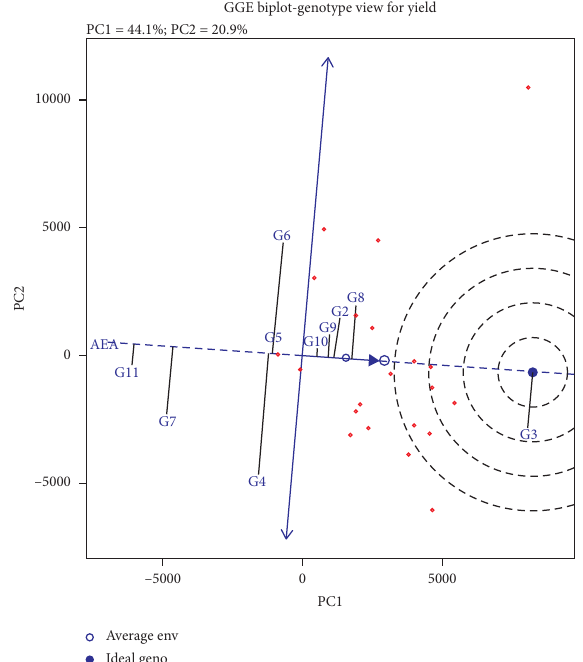
Figure 2: The GGE biplot viewing position of maize hybrids compared to an ideal genotype for the following cropping systems for rainy and dry seasons. The code of environments is given in Table 1. Code of genotypes is given in Table 2. PC, principal component.